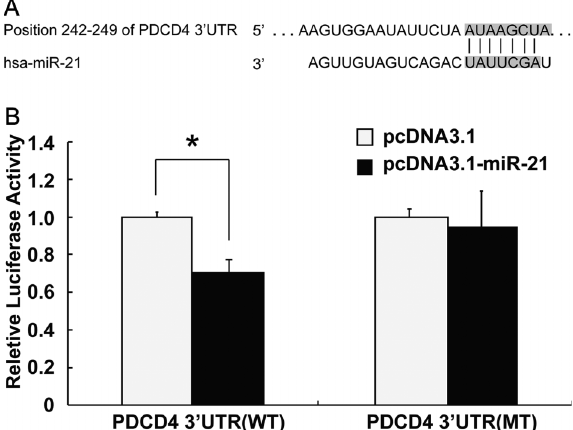
Figure 2. MicroRNA-21 (miR-21) directly targeting programmed cell death 4 (PDCD4). A : combined sequences of PDCD4 mRNA and microRNA-21 in 3 0 -UTR binding site; B , Dual-luciferase reporter analysis results: the activity of luciferase showed no signi fi cant difference in the group transfected with carriers of miR- 21 and mutant (MT) PDCD4 mRNA (P 4 0.05), while the activity of luciferase was signi fi cantly decreased in the group transfected with carriers of miR-21 and wild type (WT) PDCD4 mRNA expressions (P o 0.01); *P o 0.05, pcDNA3.1-miR-21 group (transfected) compared to pcDNA3.1 group (negative control) (Student t- test).